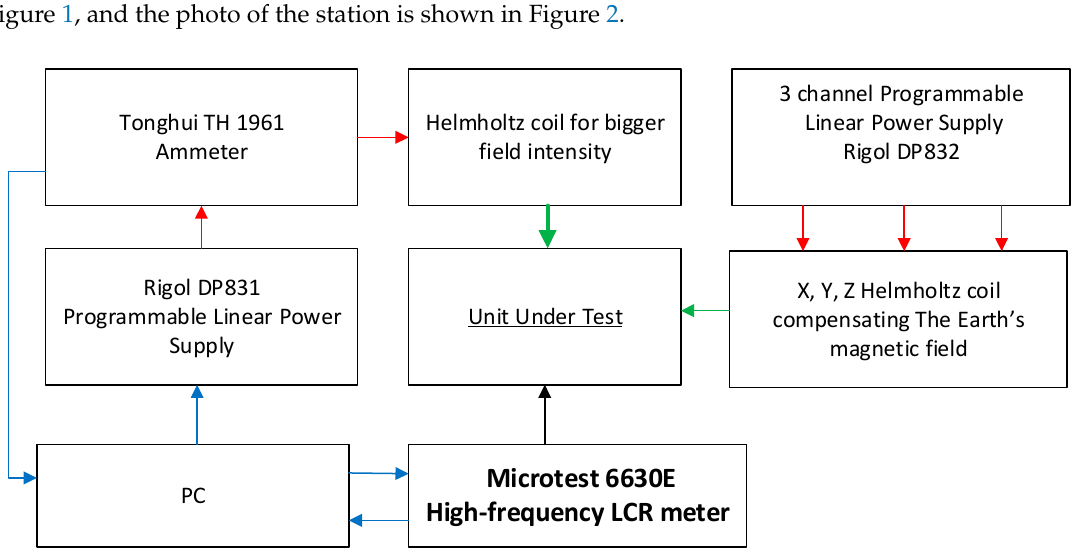
Figure 1. Block diagram of the test station for measuring the Giant Magnetoimpedance phenomenon.